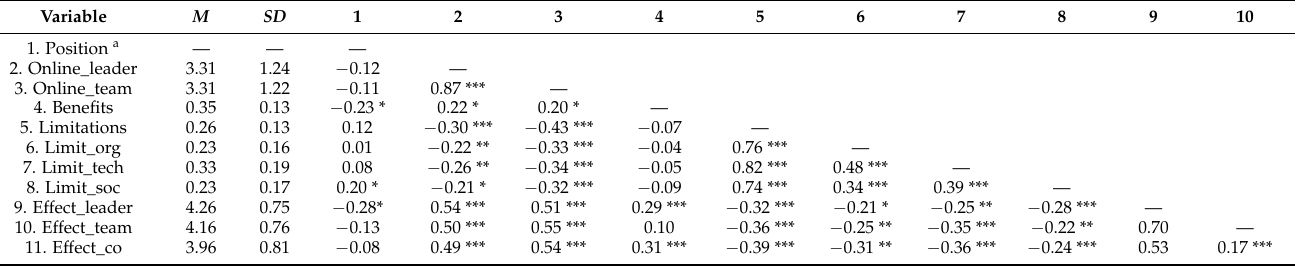
Table 1. Means ( M) , standard deviations ( SD ), and correlations between study